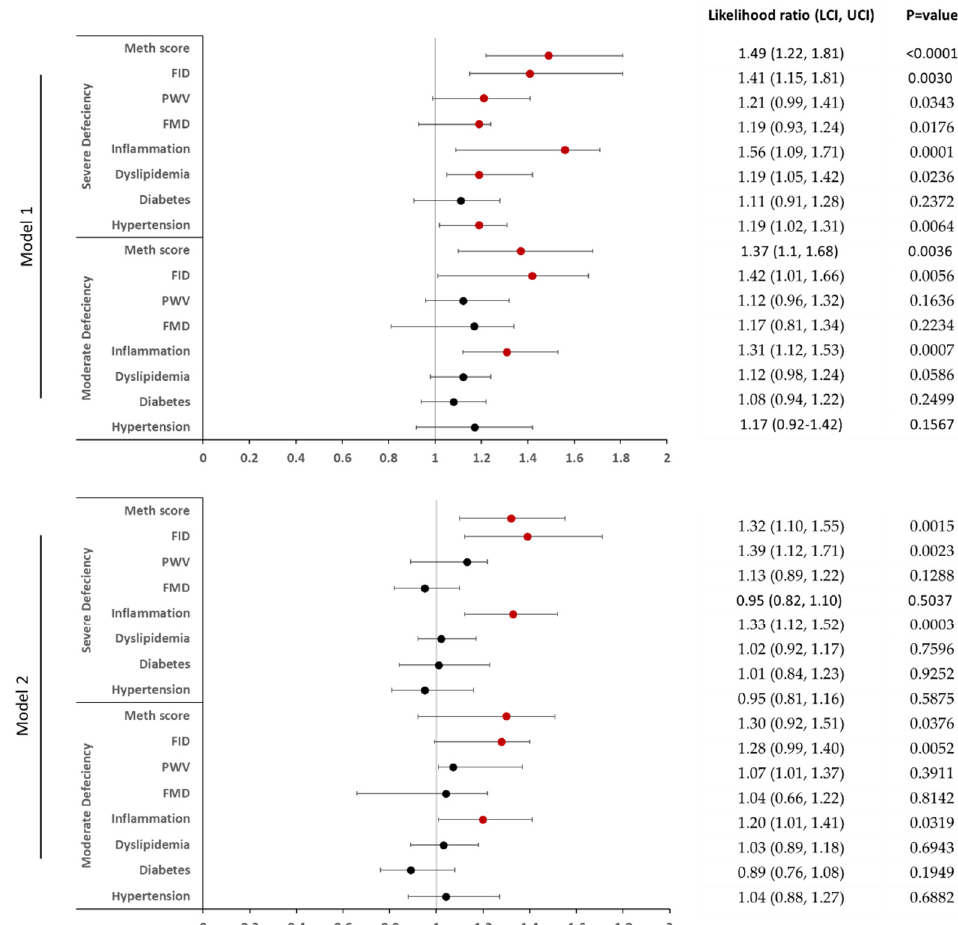
Figure 7. Vitamin D deficiency and the risk of cardiometabolic disease. Regression model 1 accounted for gender, age, and race, and regression model 2 accounted for gender, age, race, and BMI. Hypertension (clinical history or SBP/DBP ≥ 130/80 mmHg); dyslipidemia (triglycerides ≥ 150 mg/dL, total cholesterol ≥ 200 mg/dL, LDL ≥ 100 mg/dL; or HDL < 40 mg/dL); diabetes (clinical history of diabetes or fasting blood glucose ≥ 126 mg/dL); systemic inflammation (CRP > 3.5 mg/dL or IL-6 > 17.5 pg/mL); arteriolar FID (<33.8%); PWV (>10.1 ms − 1 ); brachial artery FMD (<8.0%); inflammatory gene methylation score (<43.2%). FID, flow-induced dilation; FMD, flow-mediated dilation; LCI, lower confidence interval; PWV, pulse wave velocity; UCI, upper confidence interval. Red circles indicate significant p -values.